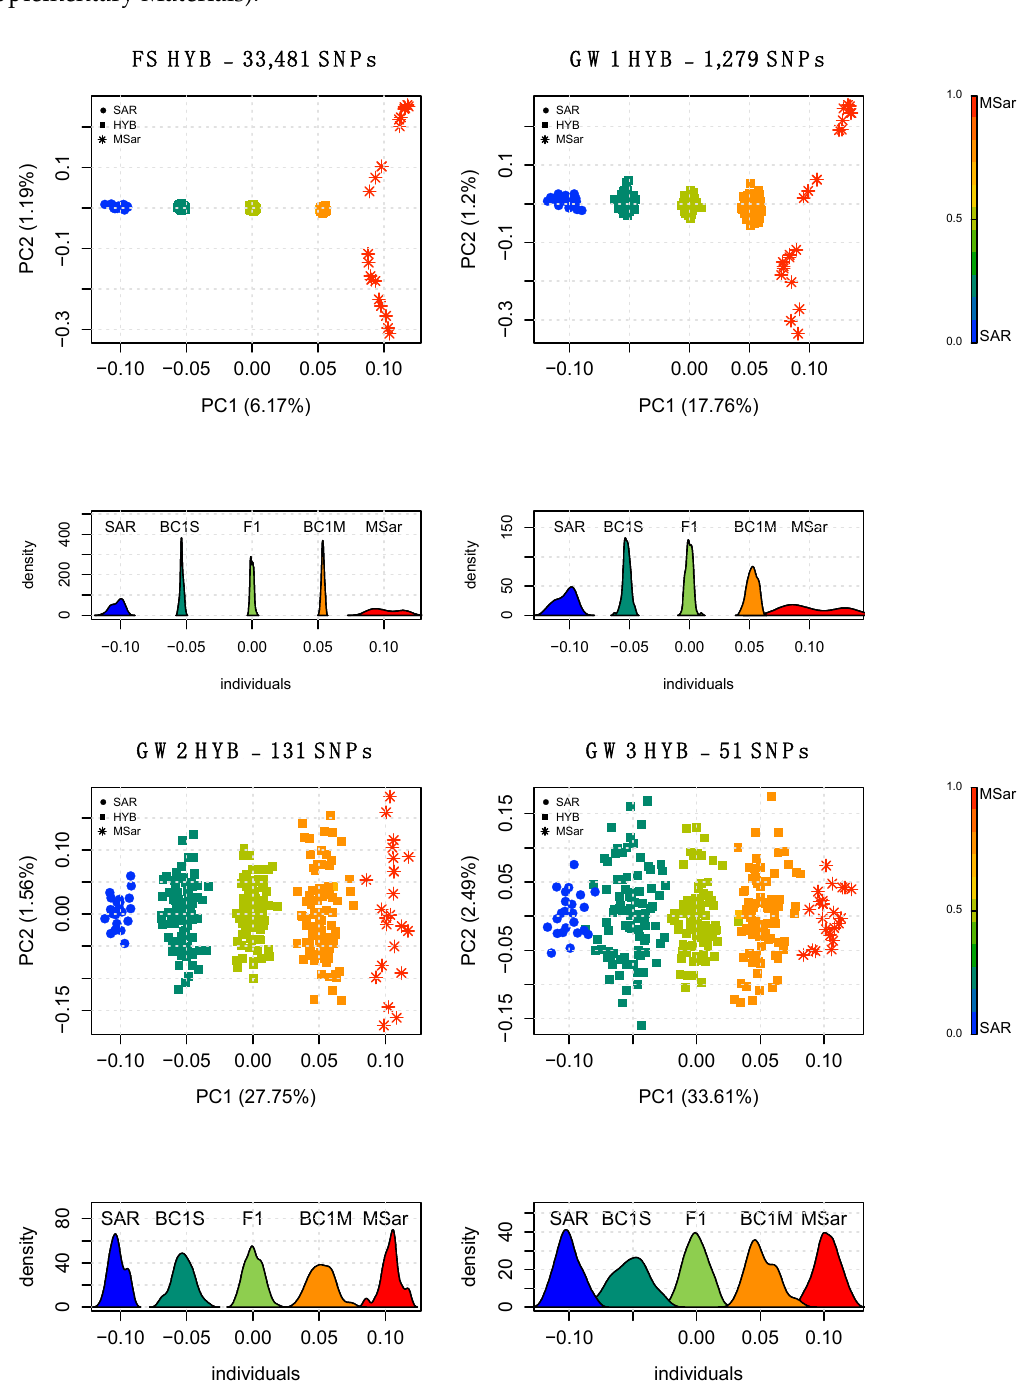
Figure 2. PCA and density distribution of the PC1 obtained using the full SNP set (top-left panel) and three AIMs on reference populations and simulated hybrids (HYB) using the genome-wide discovery approach. BC1S and BC1M are the simulated F1 backcrossed with SAR and MSar, respectively. The gradient legend on the right side of the plot shows the transition gradient from sheep to mouflon genetic